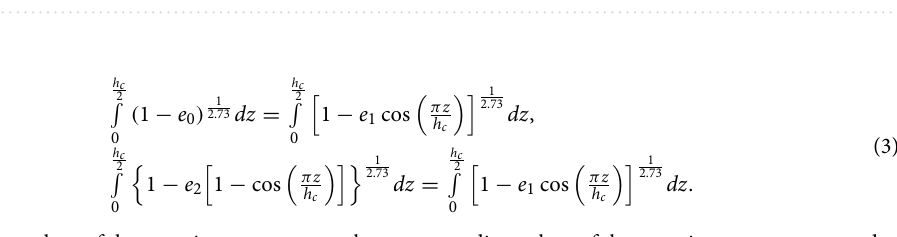
For some values of the porosity parameter e 1 , the corresponding values of the porosity parameters e 0 and e 2 can be found in Table 1 and can be approximately stated as bellow 36 :